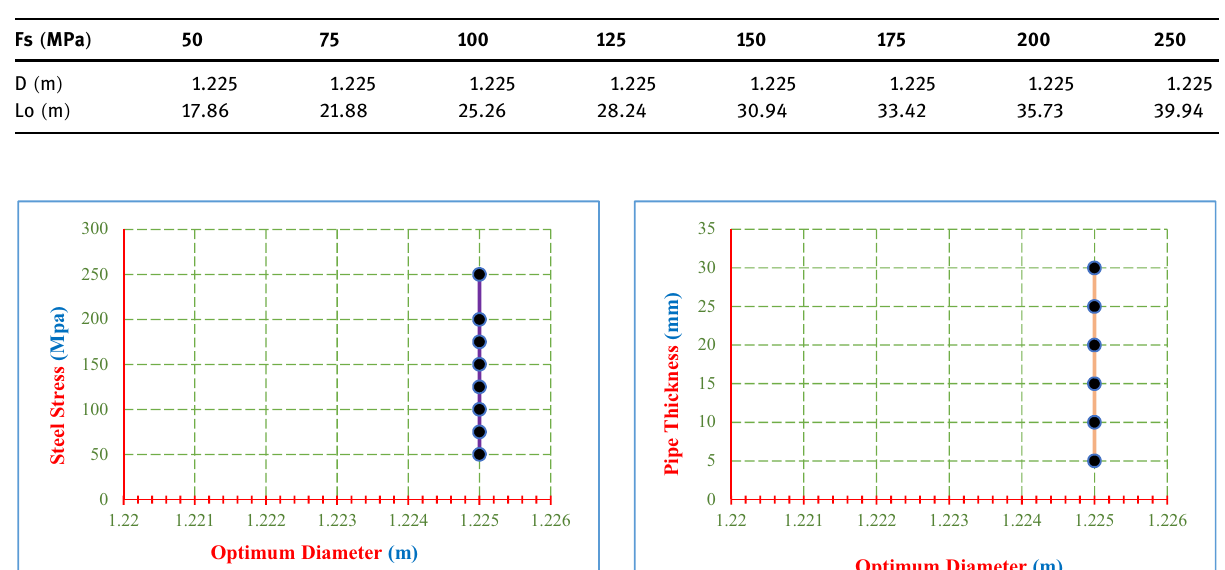
Table 8: Steel stress vs optimum diameter and safe span length